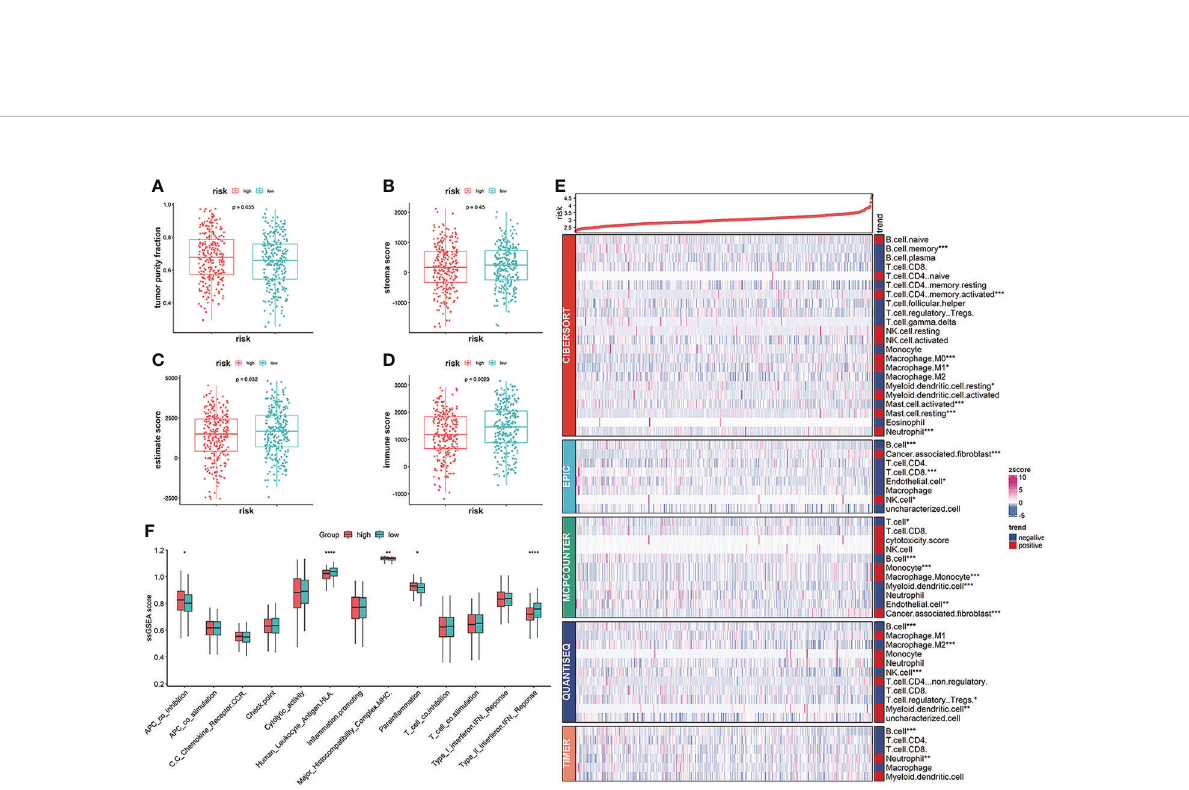
FIGURE 7 Correlation of vesicle-mediated transport-related gene signature with immune cell in fi ltrations in the TCGA cohort. (A, B) Stromal scores and tumor purity fractions between the risk groups. (C, D) Differences in immune and estimate scores between the two risk groups were signi fi cant. (E) Differences in abundance of immune cell in fi ltration between the high-risk and low-risk groups. (F) ssGSEA scores of immune functions between the high- and low-risk groups. * p <0.05, ** p <0.01, *** p <0.001, **** p